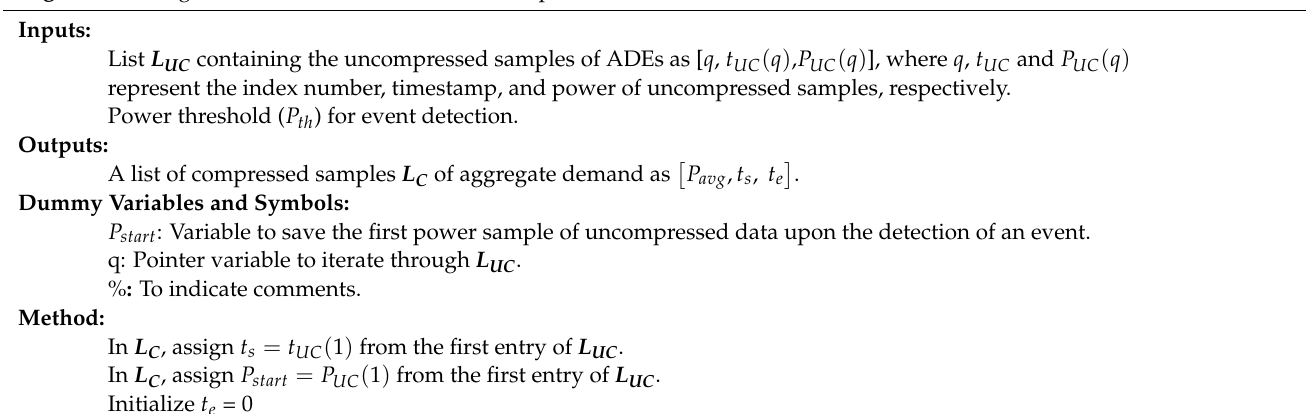
Algorithm 2: Algorithm for Event-Driven Data